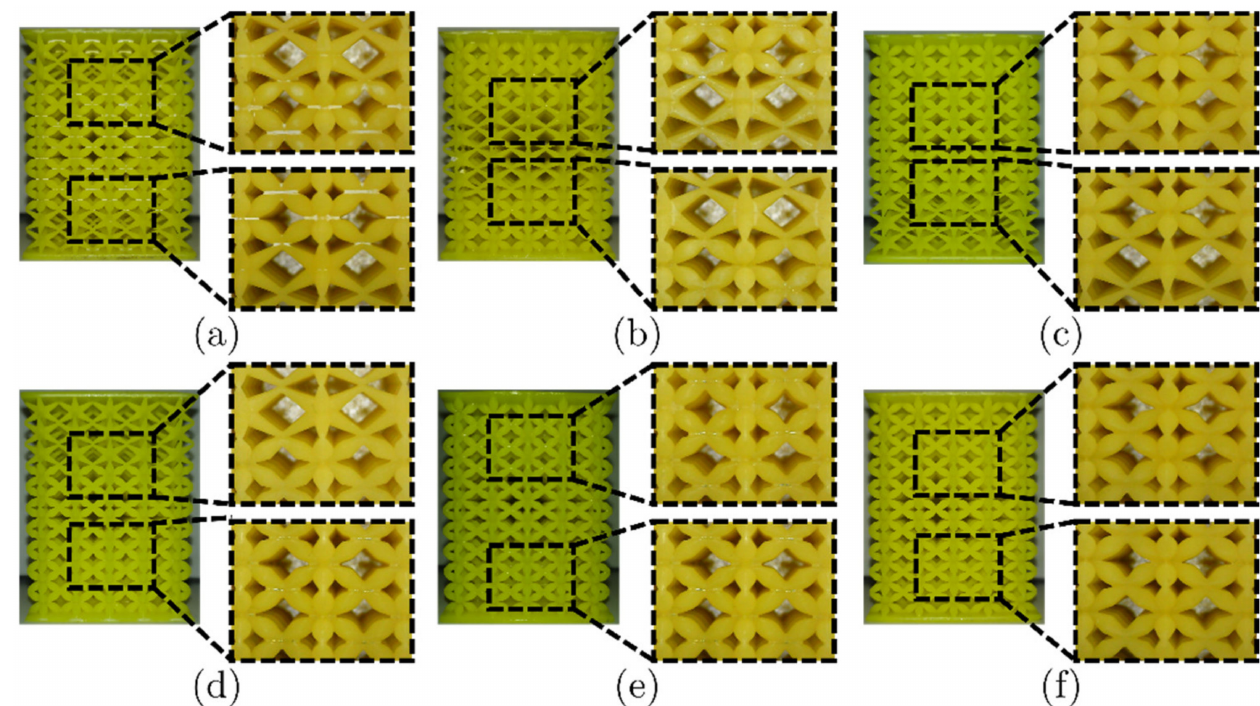
Figure 13. LLS printed via LCD: ( a ) HM-LM-HM, ( b ) LM-HM-LM, ( c ) HM-IM-LM, ( d ) LM-IM-HM, ( e ) LM-IM-LM and ( f ) IM-LM-IM.